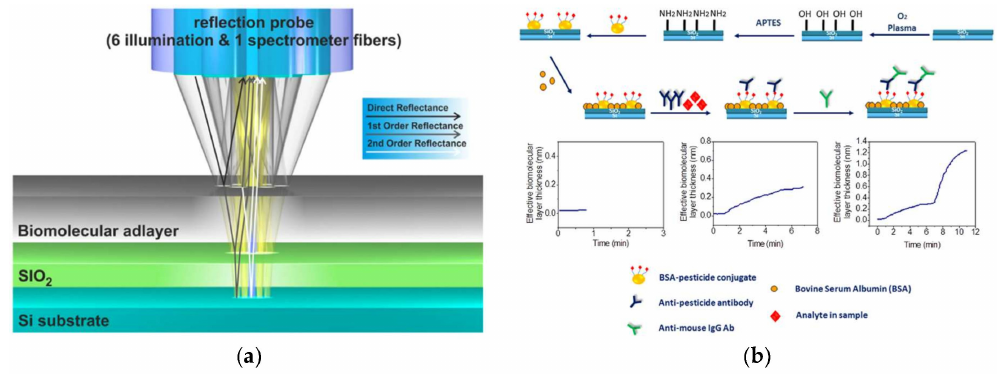
Figure 4. ( a ) White light reflectance spectroscopy principle of operation. ( b ) Schematic of the activation/biofunctionalization procedure of the chip surface and the competitive assay for the determination of pesticides (Reprinted with permission from [107]).